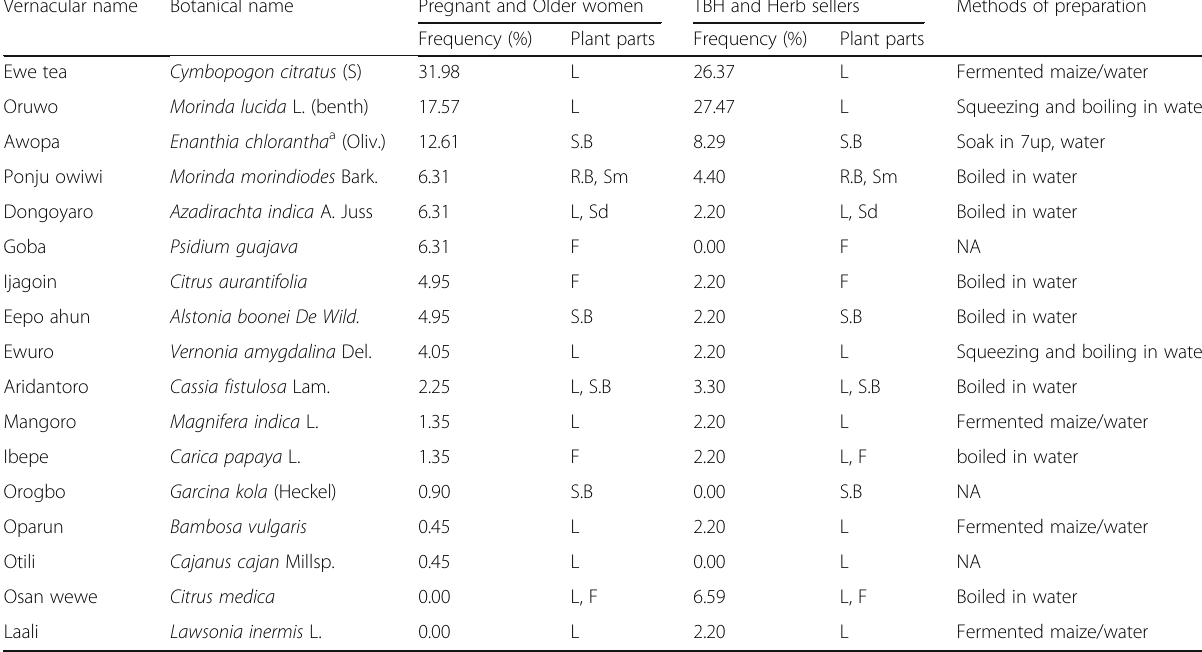
Table 2 Response on common antimalarial plants and parts used in